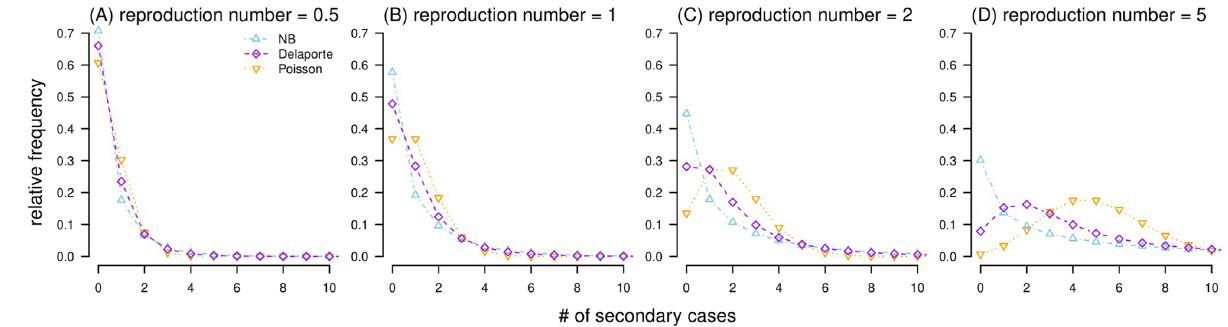
Fig 1. Probability mass functions (PMF) of Poisson (in orange), negative binomial (in blue), and Delaporte (in purple) distributions. In each panel, the dispersion parameter k is fixed at 0.5, and the fraction of fixed component ρ is fixed at 0.3.